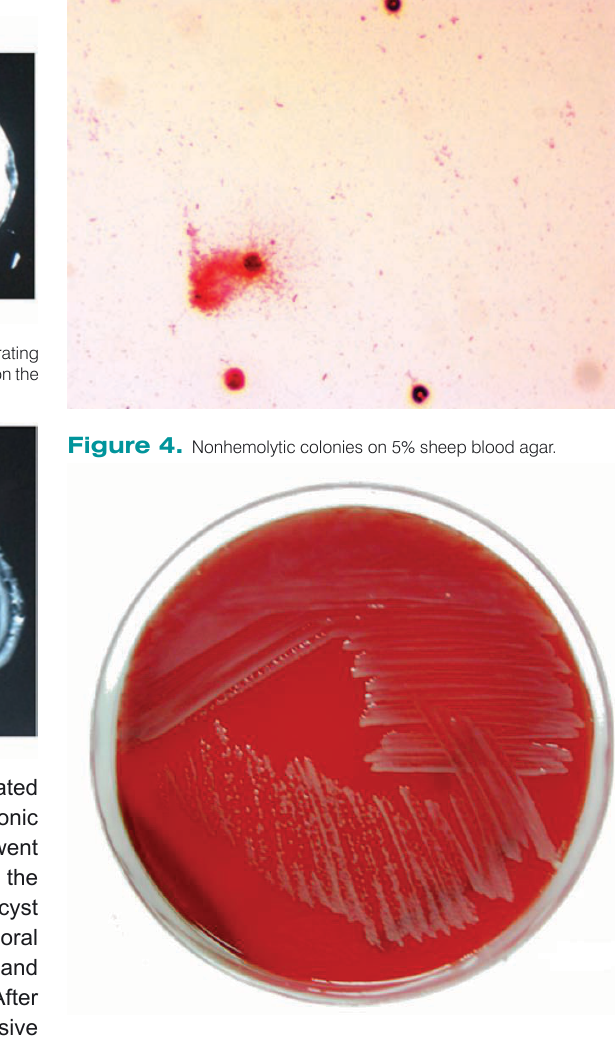
Figure 1. Axial CT showing a left temporal arachnoid cyst (A) and a chronic subdural hemorrhage (B).